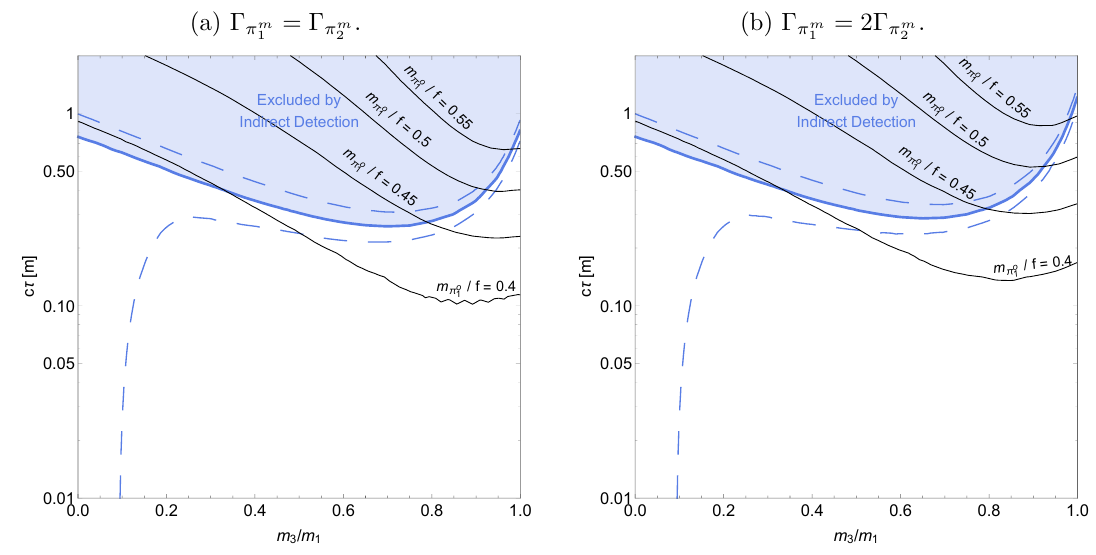
Figure 5. Allowed region of parameter space for the benchmark CIc for di(cid:11)erent ratios of the decay widths. The mass of (cid:25) o is kept at a constant value of 75 GeV. The contour lines represent constant 1 values of m (cid:25) o =f . The blue region is excluded by indirect detection dark matter searches. The dashed 1 blue lines correspond to what the exclusion limit would be if the limit on the indirect detection e(cid:11)ective cross section were to vary by (cid:6) 10%. The decay length is that of the lightest unstable